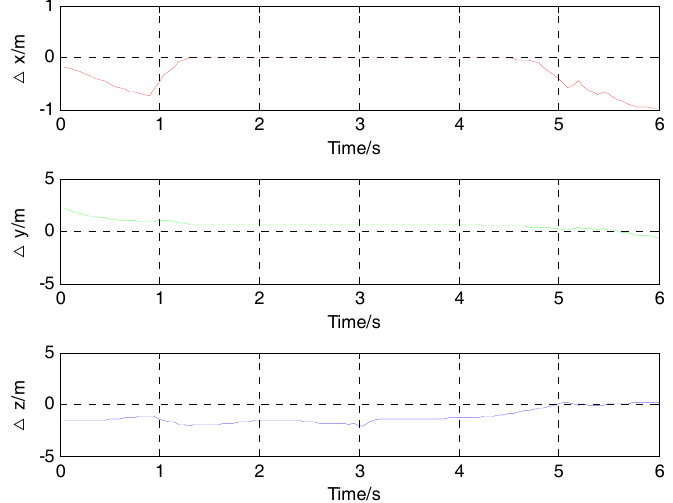
Figure 10. The overhead view of three collinear magnetic sensors.